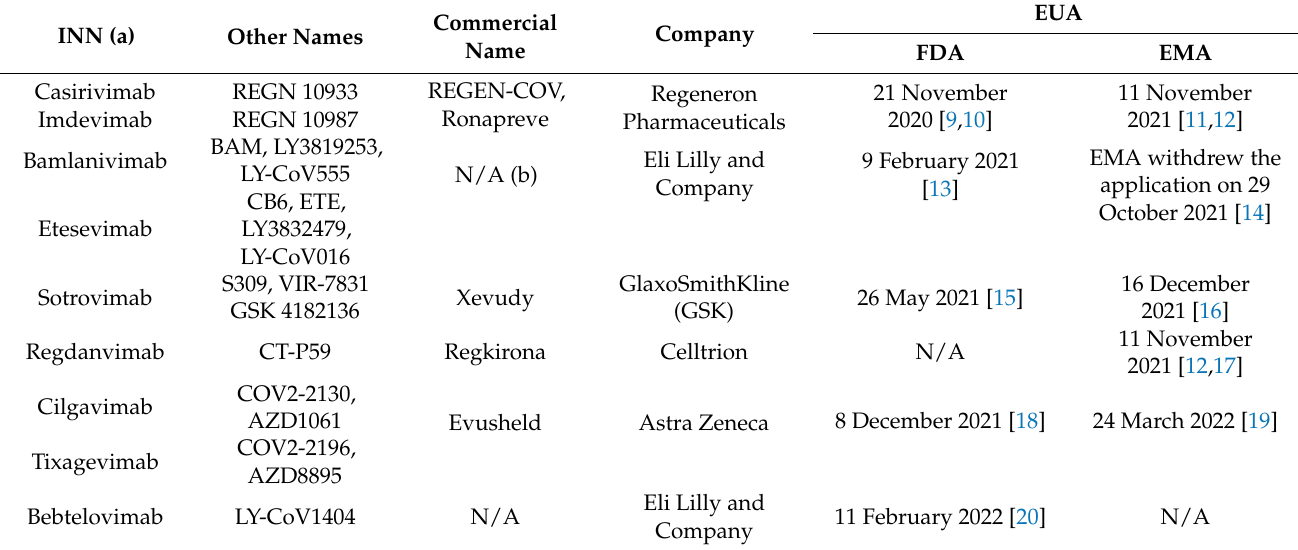
Table 1. FDA and/or EMA EUA therapeutic antibodies to treat